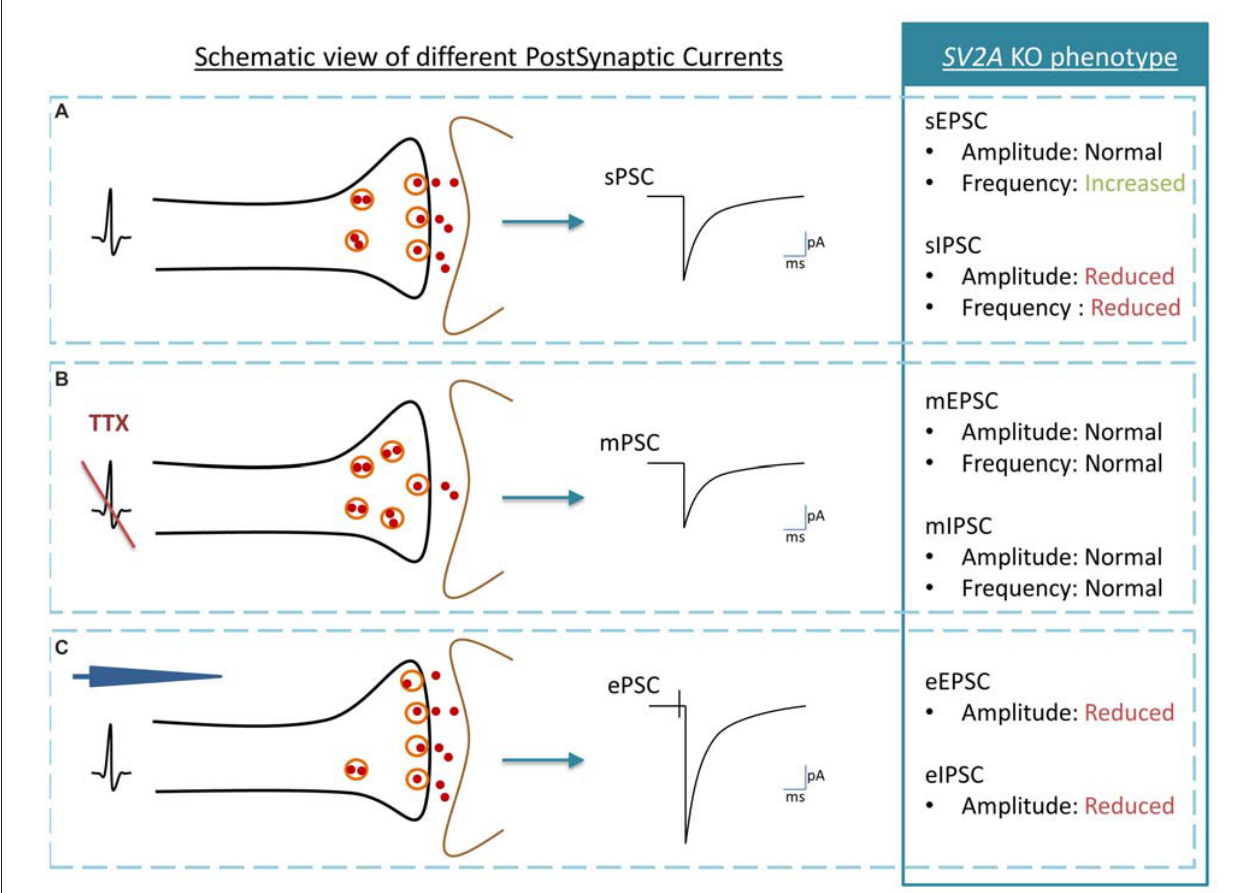
FIGURE 1 | Schematic view of post synaptic currents (PSC) and summary of Synaptic vesicle proteins 2A (SV2A) KO phenotype. (A) Spontaneous PSC or sPSC: an action potential in the presynaptic neuron (black) induces a sPSC in the postsynaptic neuron (brown). (B) Miniature PSC or mPSC: the generation